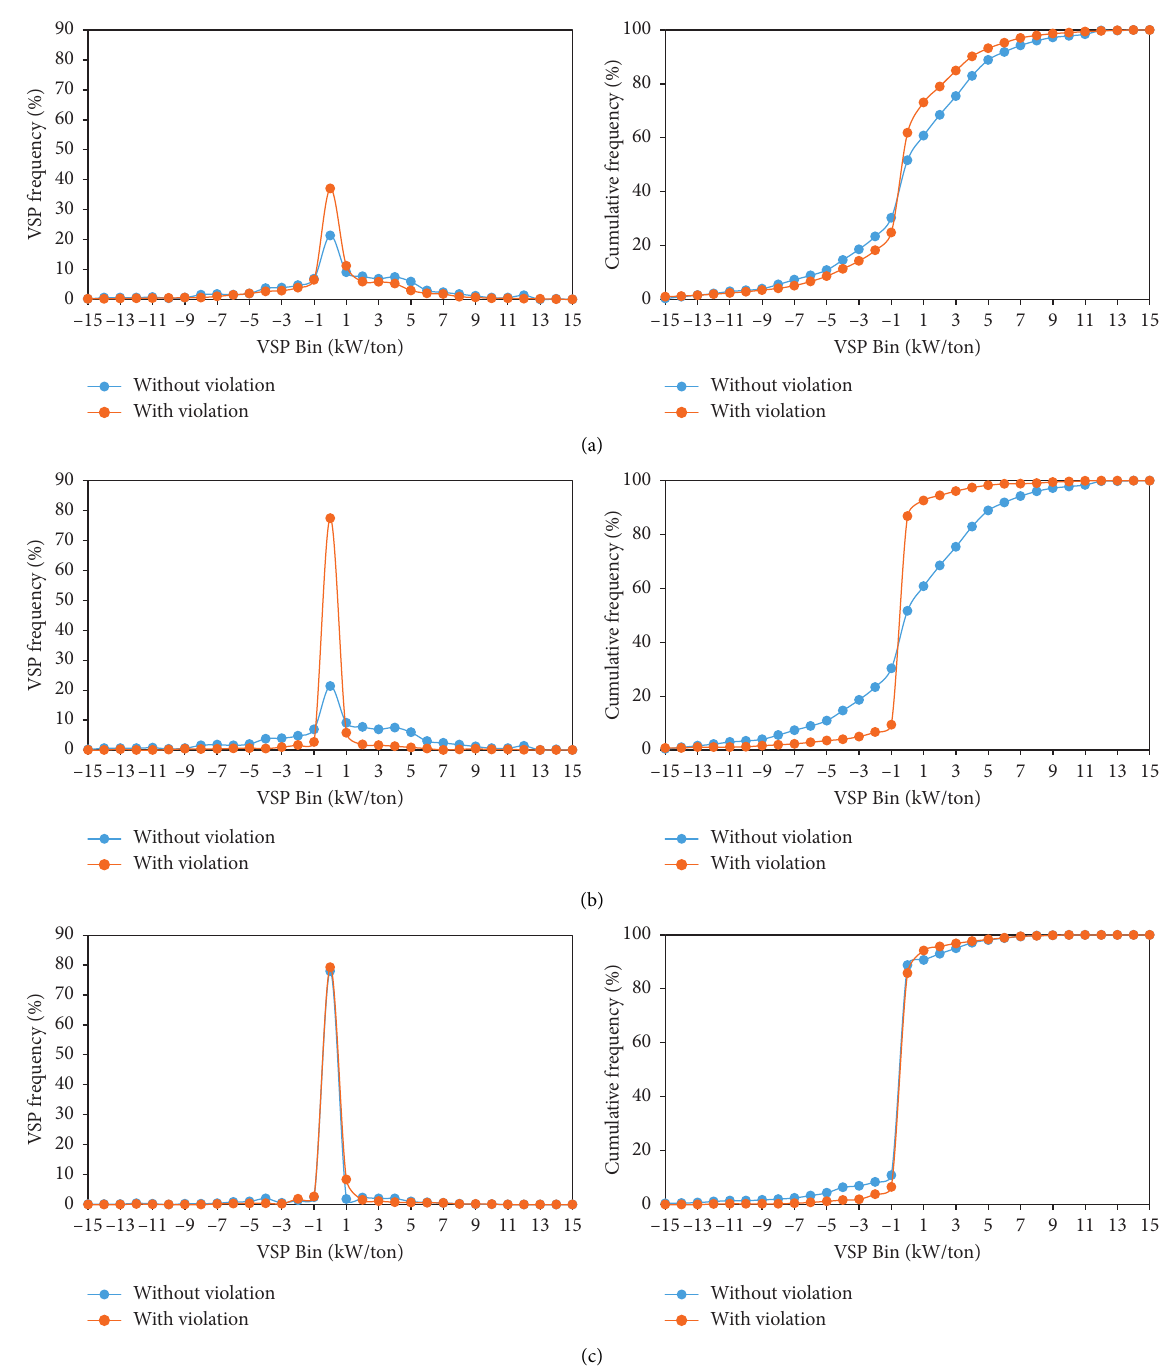
Figure 11: VSP distributions of vehicles with and without violations. (a) One-stop vehicle (type A). (b) The vehicle transforms from one stop to two stops (type B). (c) Two-stop vehicle (type